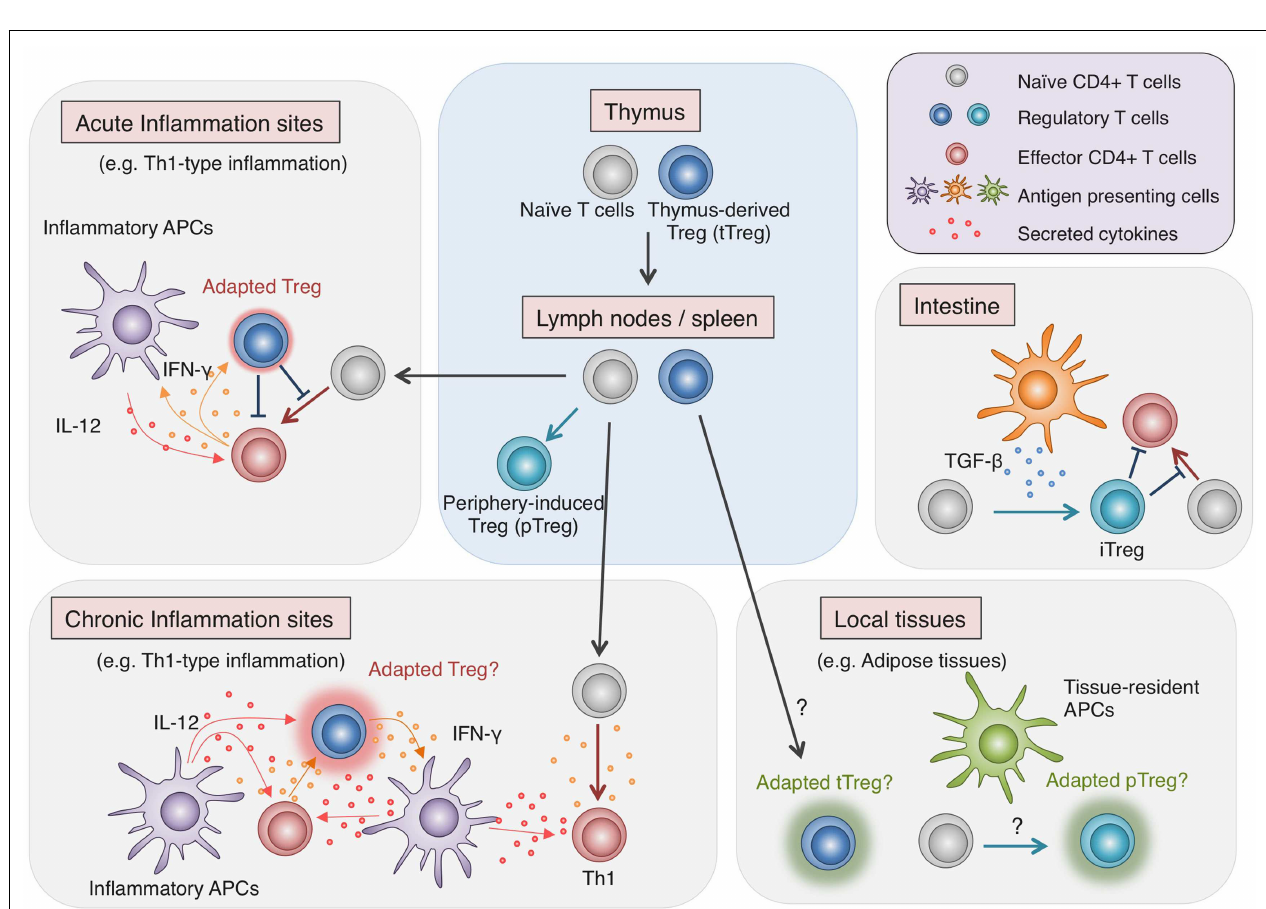
stimuli and adopt certain features of helperT cell characteristics to facilitate the immune regulation (Koch et al., 2009; Zheng et al., 2009). However, there are accumulating findings suggesting that strong stimulation by cytokines such as IL-12 induces not only the additional transcription factors and chemokine receptors but also pro-inflammatory cytokines inTreg cells (Oldenhove et al., 2009; McClymont et al., 2011; Zhao et al., 2011; Koenecke et al., 2012). Given the effects of pro-inflammatory cytokines in amplifying inflammation, possible cytokine production byTreg cells present potential hazard and might have relevance to chronic